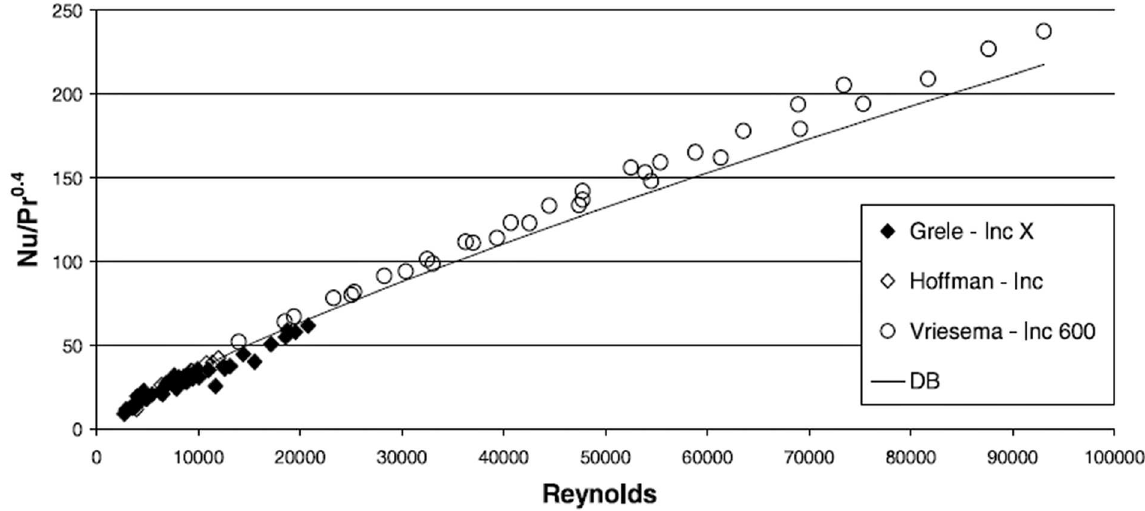
Fig. 3. Grele and Gedeon, Hoffman and Loans and Vriesema results for Inconel piping reanalyzed by Ambrosek et al. [8]. λ = 0 . 36 + 0 . 00056 .T ( W/m K) over the range of 517 ◦ C to 817 ◦ C